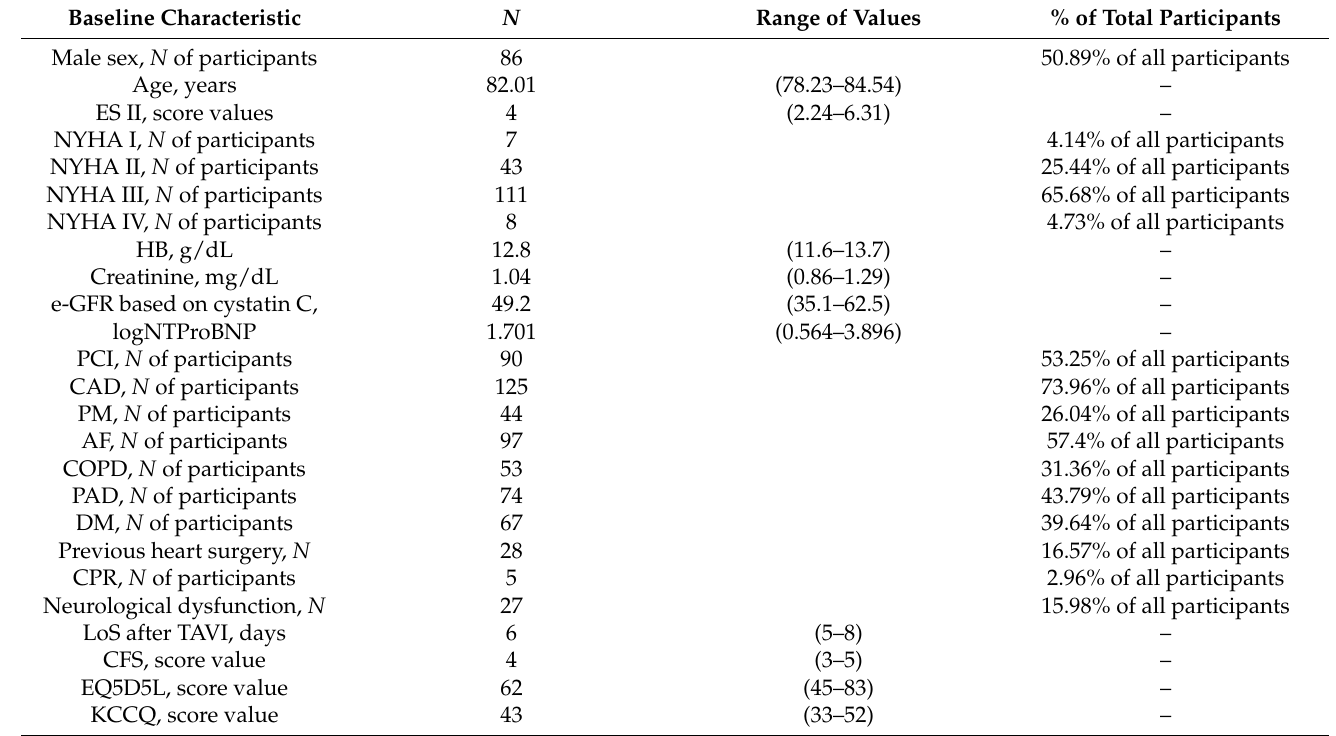
Table 1. Baseline characteristics of the study participants (number N =